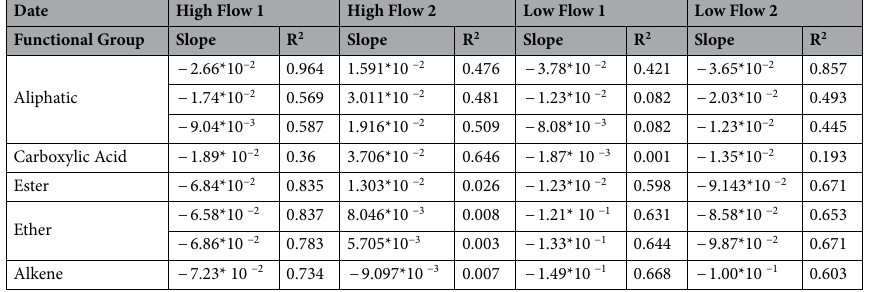
Table 2. Linear regression between peak height and iron concentration. Slope and R 2 are shown for all four dates and the five major functional groups. Regressions were done for each peak meaning functional groups with a double or triple peak have multiple